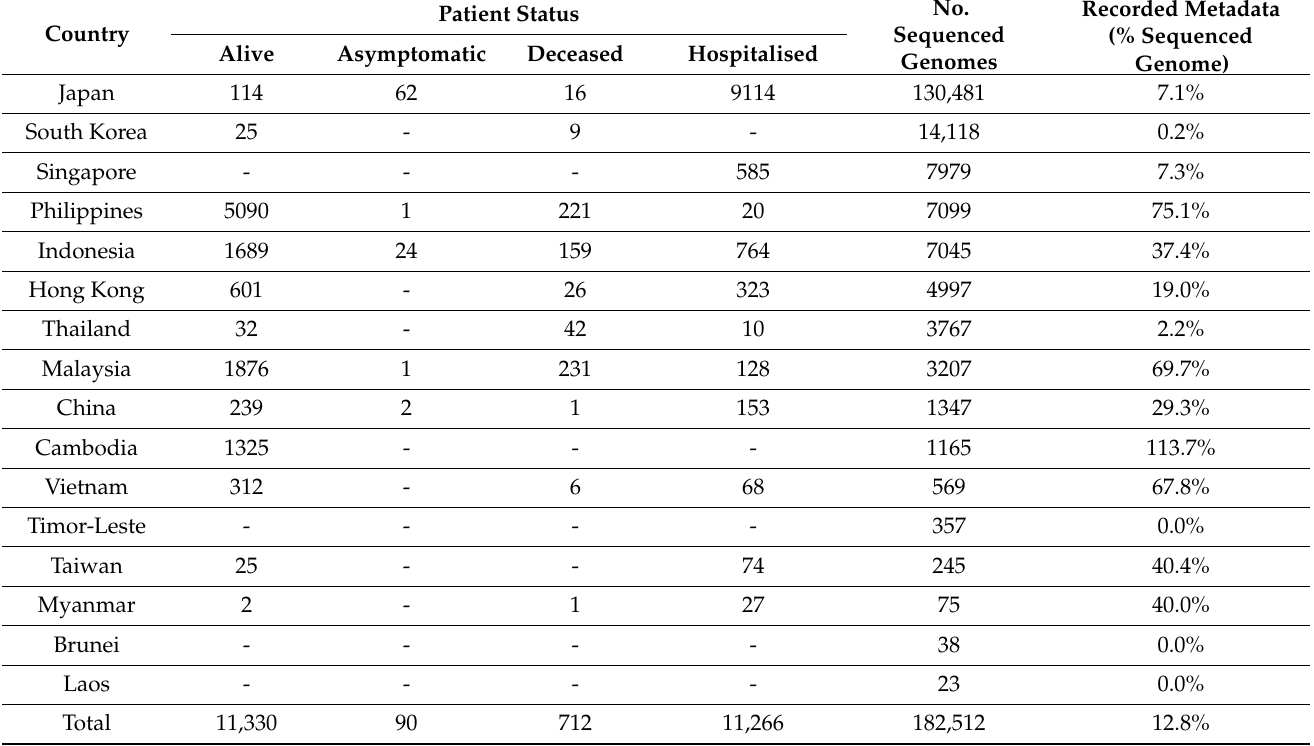
Table 1. Clinical metadata of genomes in Indonesia, Southeast and East Asia (based on data down- loaded from GISAID per 1 October 2021).